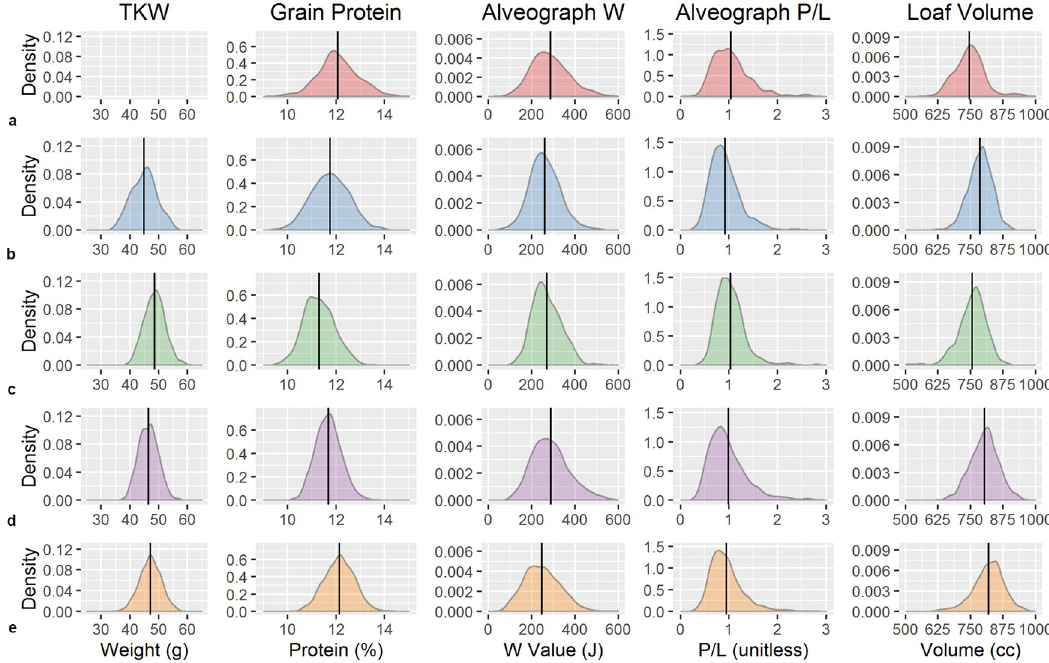
Fig 2. Distributions of phenotypic traits over time for thousand kernel weight (TKW, no data available in 2010), grain protein, Alveograph W and P/L, and loaf volume in a) 2010, b) 2011, c) 2012, d) 2013, and e) 2014.